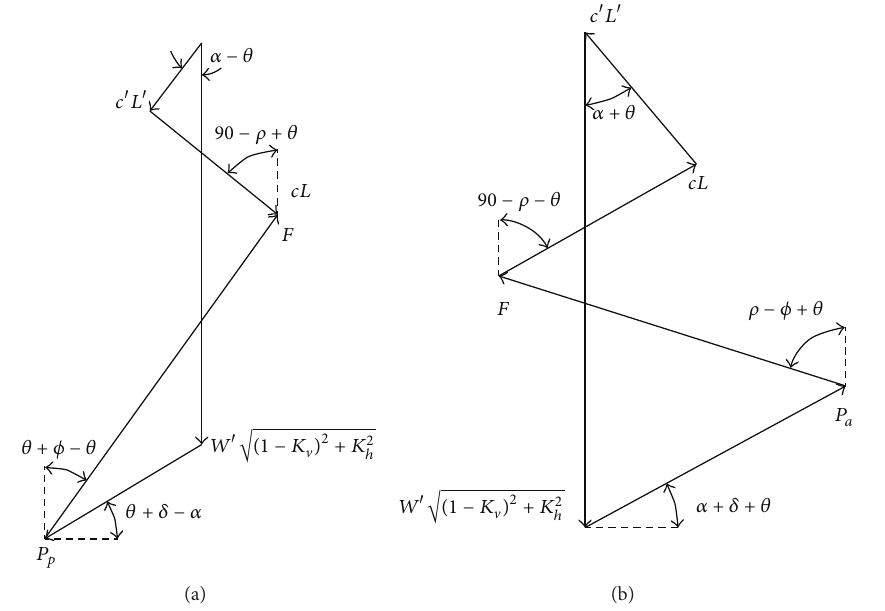
Figure 7: Effective force diagrams on failure mass (wedge).